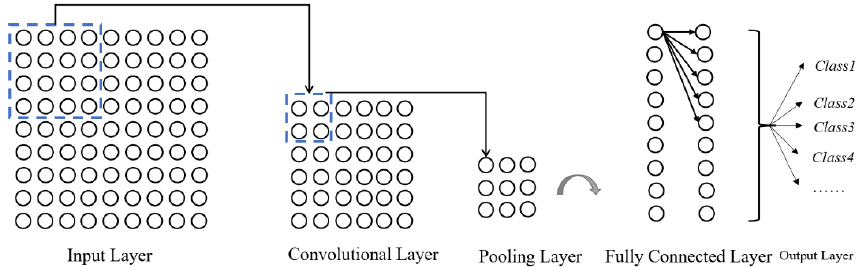
Figure 2. Basic structure of the Convolutional Neural Network.